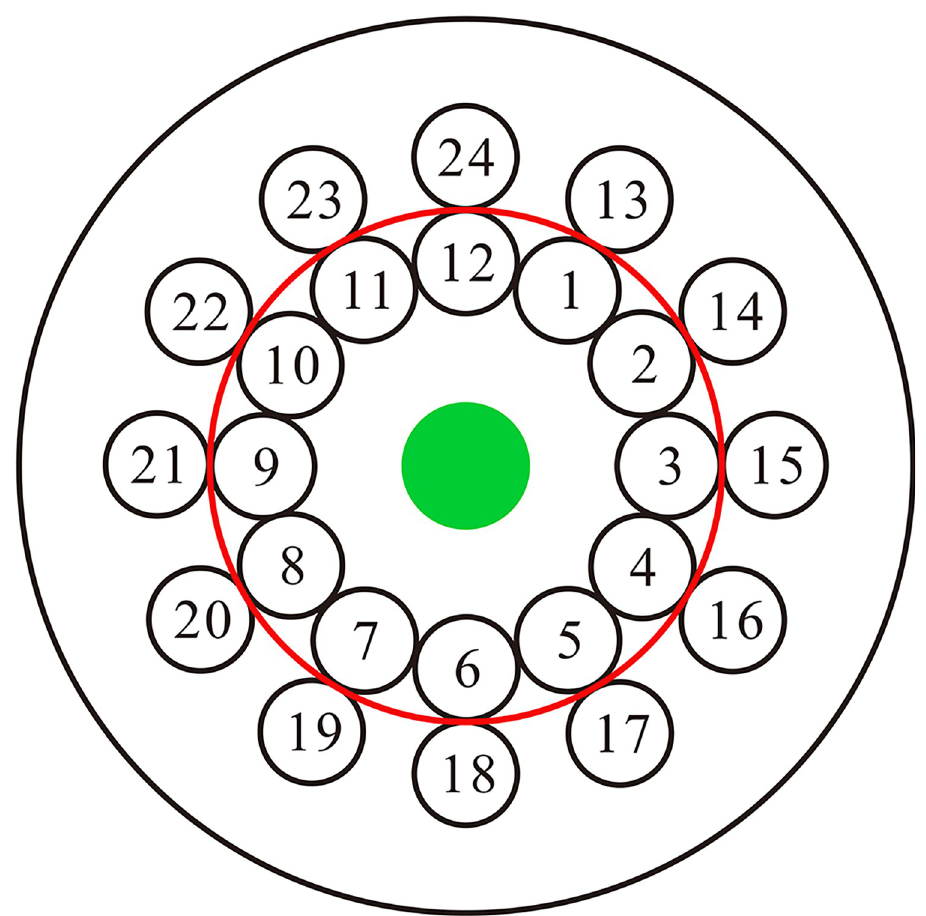
Fig 2. OCT scanning schematic diagram. The gynecologist scanned 24 locations (12 locations in the inner circle and 12 locations in the outer circle in clockwise direction) on cervical surface and saved the OCT images. Green circular area: cervical canal. Red circular strip: squamocolumnar junction